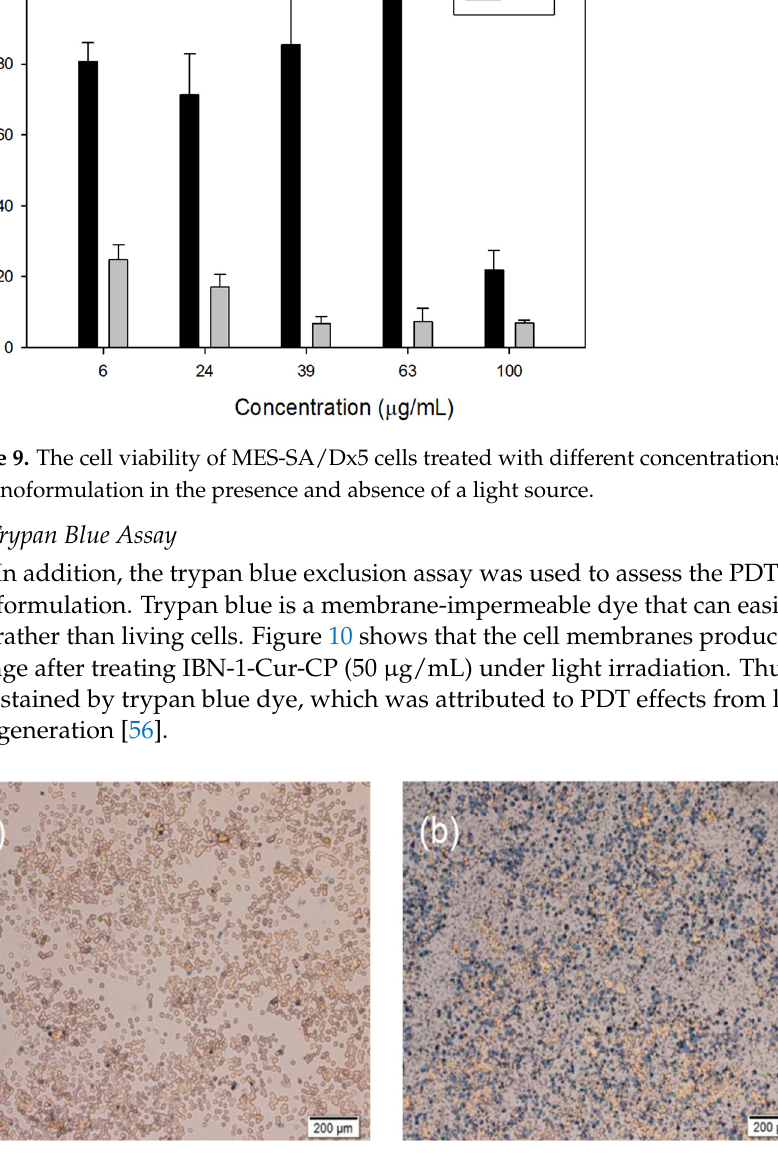
Figure 10. IBN-1-Cur-CP (50 μ g/mL) treatment in MES-SA/Dx5 cancer cells in the ( a ) absence and ( b ) presence of light irradiation as measured by the trypan blue assay (scale bar 200 μ m).